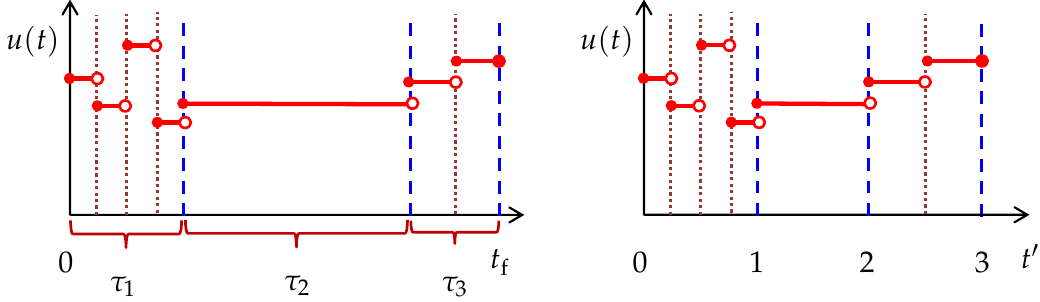
Figure 3. Schematic of the semi-uniform control discretization in the real time domain t (left) and the transformed time domain t ′ (right). The three transient and turnpike phases are delineated by the blue dashed lines.